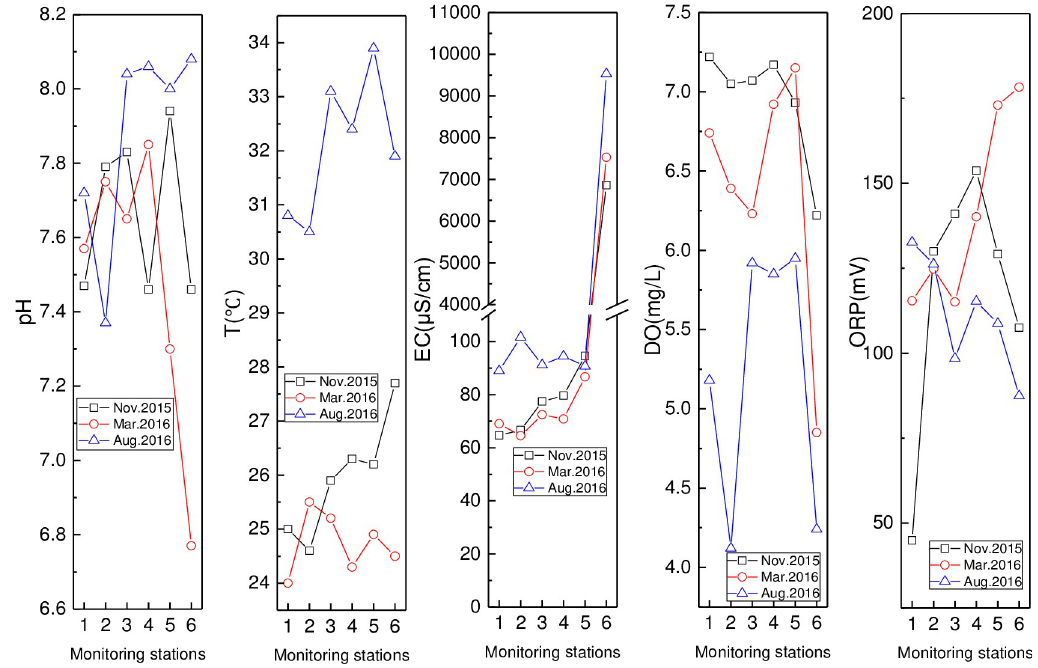
Fig 2. Variation of pH, T, EC, DO, and ORP in Wenchang River (monitoring stations including HN07, HN06, HN05, HN04, HN02, and HN01 were represented by numbers from 1 to 6).